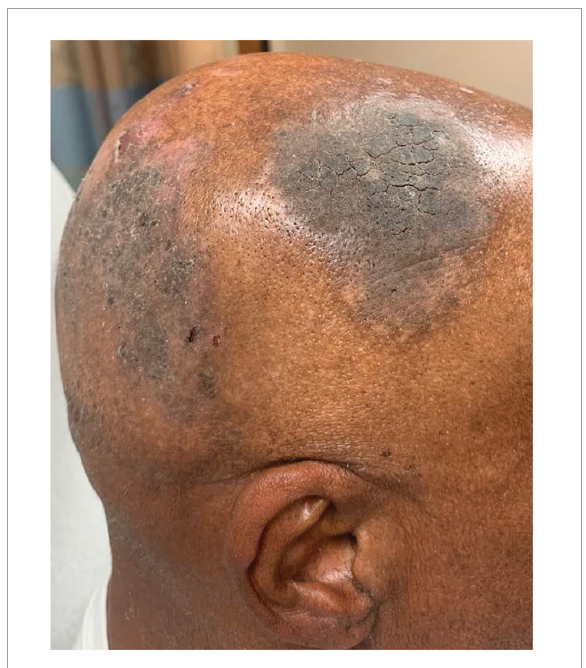
FIGURE4 Mounded and refractory keratoses as an early presentation of pemphigus vulgaris recurrence. In this patient (Case 3), there were no blisters present on the body or